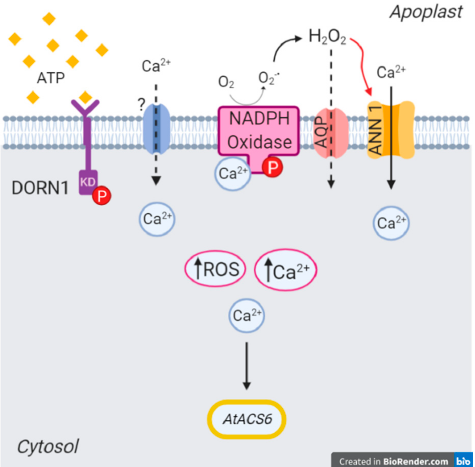
Figure 11. eATP perception by AtDORN1 at the root epidermal plasma membrane could be upstream of AtANN1 via production of extracellular ROS. Perception of eATP by AtDORN1 activates as yet unknown Ca 2+ influx channels. AtDORN1 could phosphorylate an NADPH oxidase (AtRBOHC and AtRBOHD being the most likely candidates) with its kinase domain (KD) and the NADPH oxidase could also be activated by [Ca 2+ ] cyt at its EF hands. This would result in production of extracellular hydroxyl radicals that could readily be converted to peroxide (H 2 O 2 ) or hydroxyl radicals [26,27]. These could promote AtANN1-mediated Ca 2+ influx. Peroxide could enter the cytosol through aquaporins (AQP) [54], which could account for eATP-induced intracellular ROS accumulation. The latter is the clearest point for the divergence between eATP and eADP pathways. Decoding of [Ca 2+ ] cyt as a second messenger leads ultimately to a nuclear transcriptional response that can be impaired in Atann1. The position of AtP2K2 in such a pathway has yet to be tested. This original figure was created with